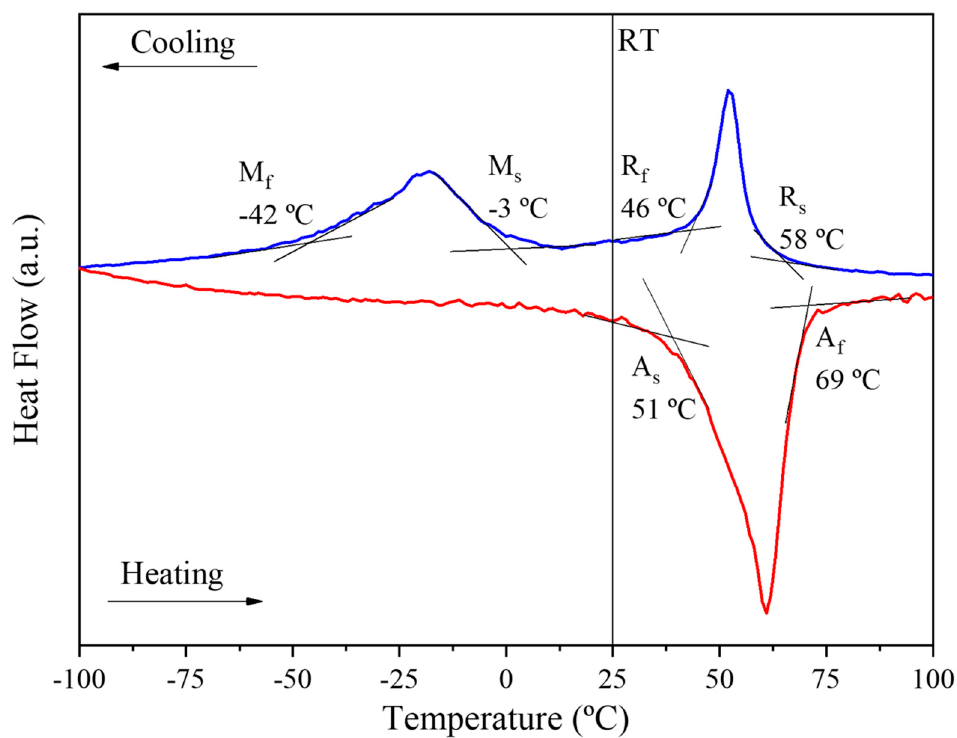
Figure 3. DSC curve of NiTi spring.